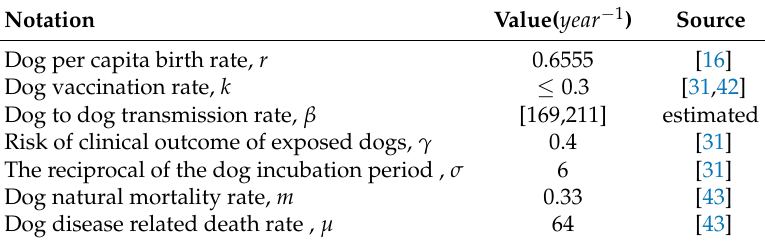
Table 1. Parameter values for numerical